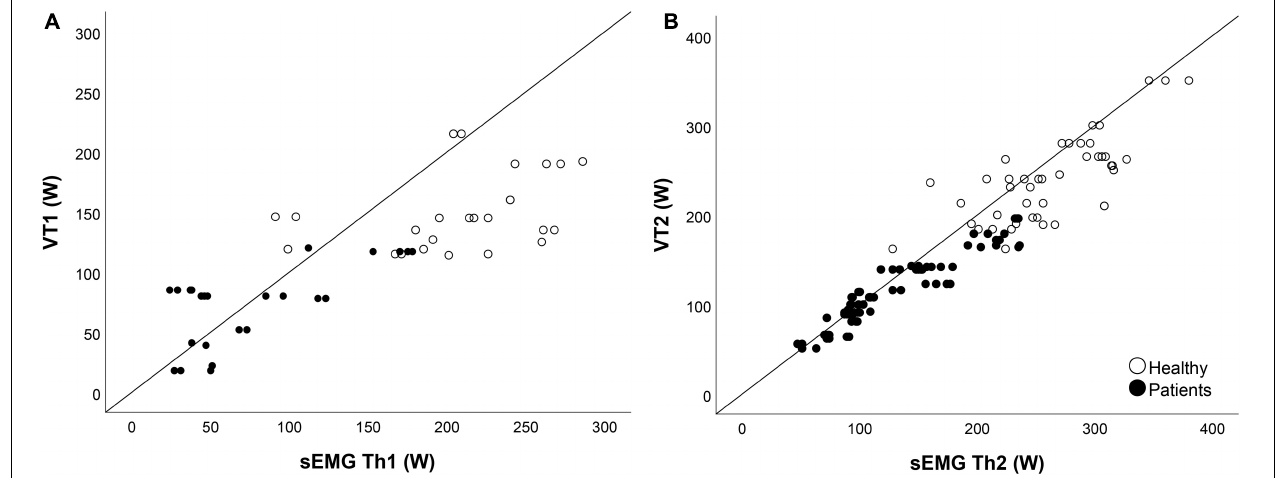
FIGURE 5 | Validity. Panel (A) shows the scatterplot of the first ventilatory threshold (VT1) compared to the first surface EMG threshold (sEMG Th1). Panel (B) shows the scatterplot of the second ventilatory threshold VT2 compared to the second surface EMG threshold (sEMG Th2). Open circles represent the healthy controls, closed circles represent the neuromuscular disorder (NMD) patients. For the sEMG Ths, all muscles are combined, so data of six muscles are shown.